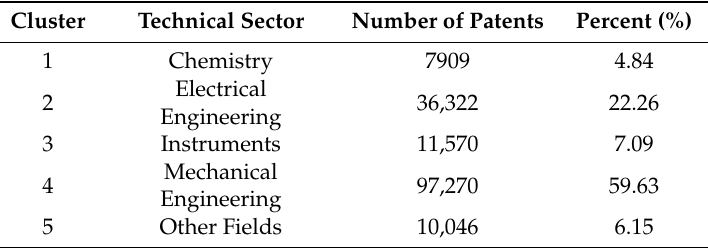
Table 3. K-Means clustering results ( K = 5).